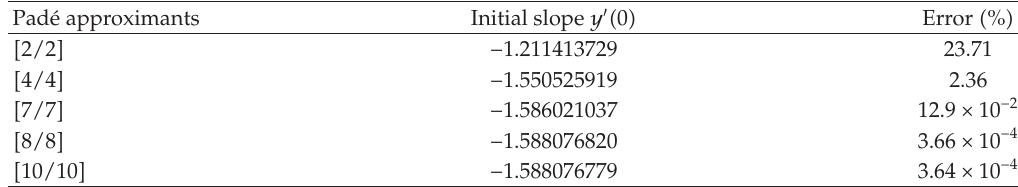
Table 1: Pad´e approximants and initial slopes y (cid:6) (cid:3) 0 (cid:4) (cid:6) 56 (cid:7) . Pad´e